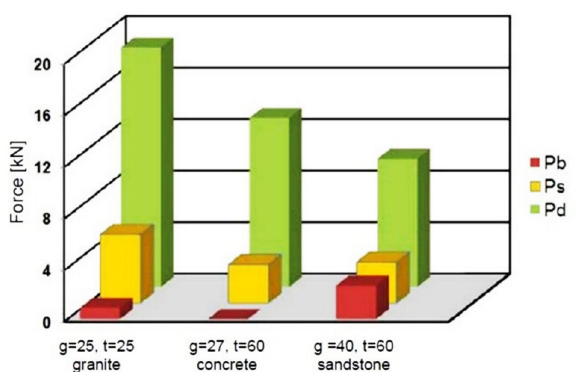
Figure 18. Mean values of mining forces for maximal values of mining depth and mining spacing during mining different rock samples in the vertical plane [30].